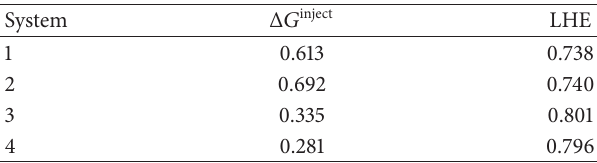
Table 4: Free energy of electron injection Δ𝐺 inject (eV) and light harvesting efficiency